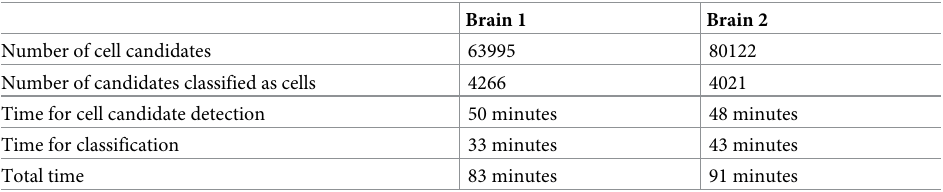
Table 2. Algorithm timings on a laptop computer with Intel i9–9900K CPU, 32GB RAM and an NVIDIA RTX2080 GPU. Data stored on an external solid-state drive.